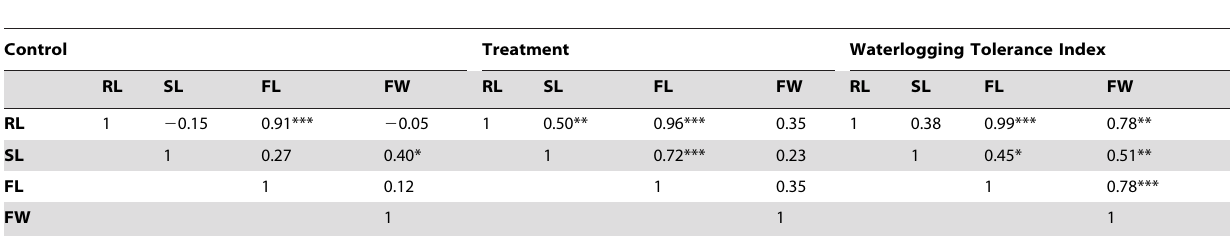
Table 4. Correlation coefficients ( r ) between pairs of traits of seedlings at seedling establishment stage under control and waterlogging.